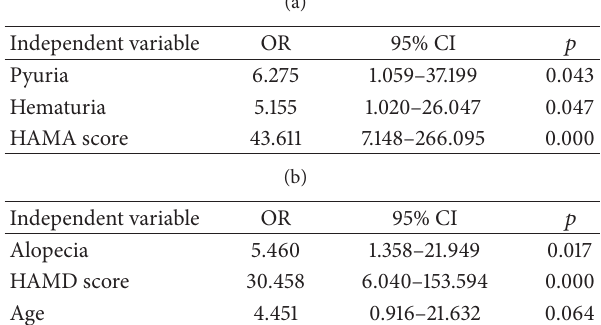
Table 2: (a) The risk factors of depression by binary logistic regres- sion. (b) The risk factors of anxiety by binary logistic